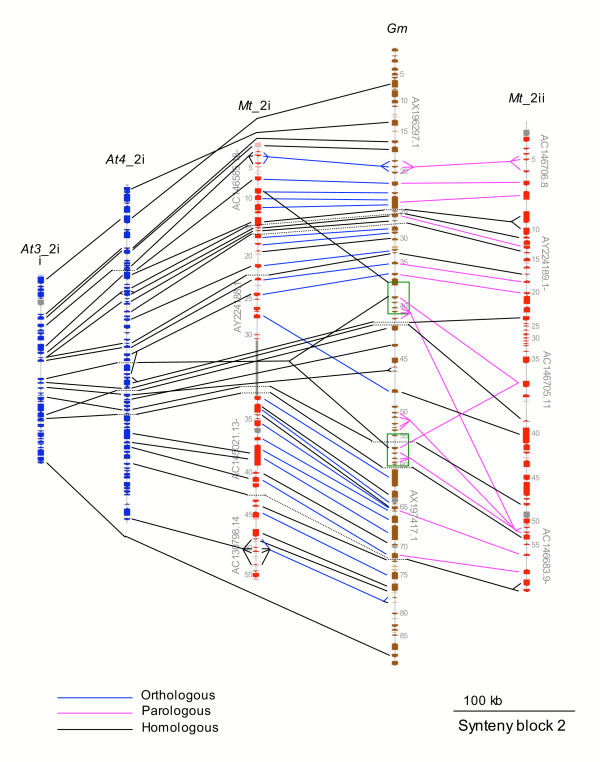
Synteny block 2. A syntenic block of soybean, M. truncatula and A. thaliana sequence assemblies surrounding soybean's Rhg4 gene (Gm gene 29). Solid black lines connect homologs. Blue lines connect orthologs. Pink lines connect paralogs. Dotted black lines indicate that the absence of a homolog in the syntenic position. M. truncatula genes are shown in red, soybean in brown, and A. thaliana in blue. Lighter colored genes represent those that had no significant similarity to Genbank's nonredundant protein database. Gray genes are repetitive elements. A thick gray line connecting sequence assemblies indicate regions in which sequence is not yet available but in which physical linkage and approximate physical distance were determined. Numbers along the sequence assemblies indicate gene numbers. Genbank accessions are shown in gray. Green boxes identify a 25 kbp duplication.